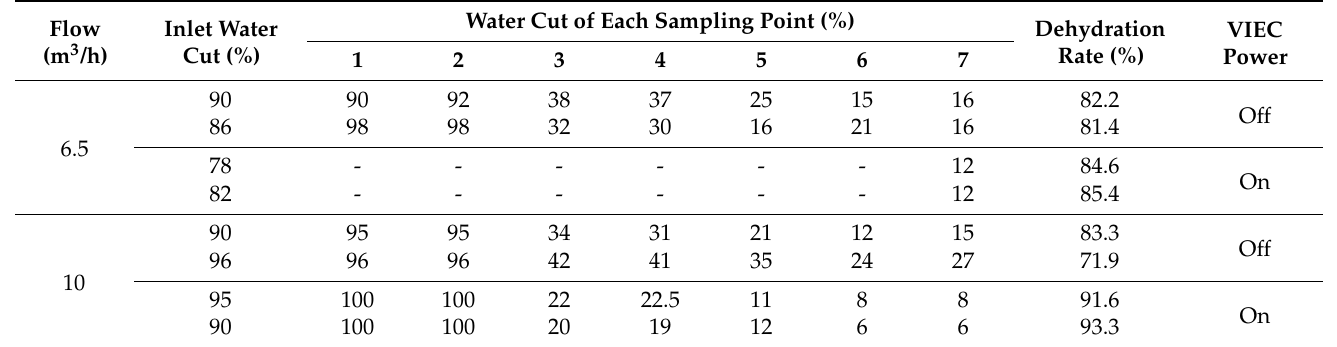
Table 2. The water cut of each sampling port in the VIEC power-on and power-off test at different inlet